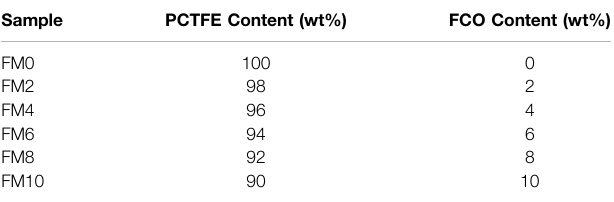
TABLE 1 | Composition of PCTFE/FCO